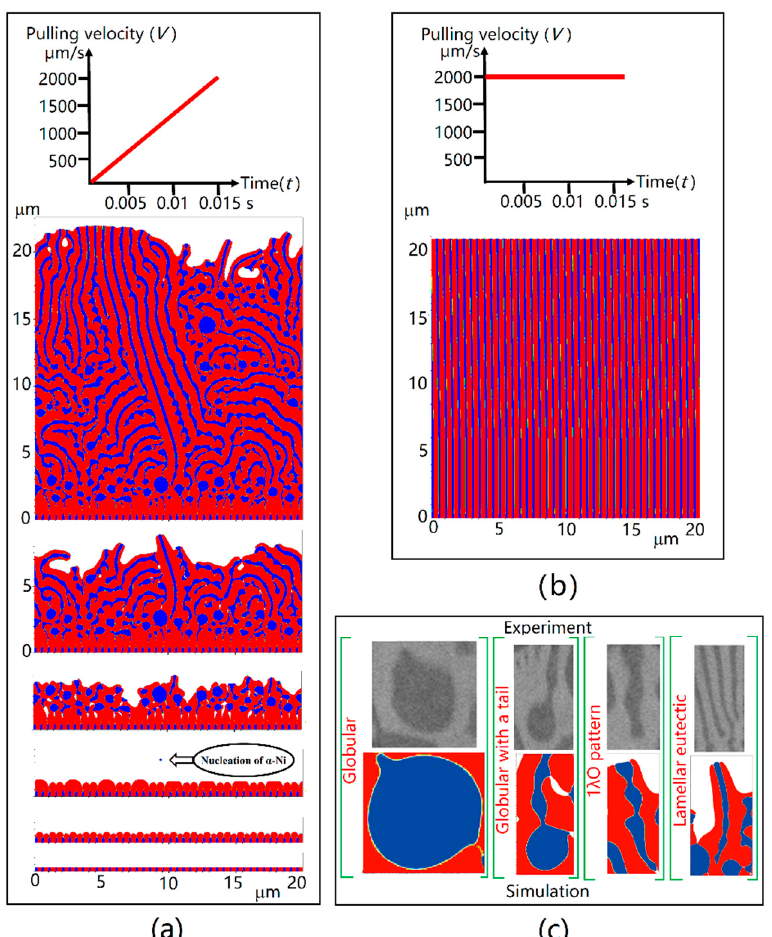
Figure 3. CA simulations of Ni-Sn anomalous eutectic growth under various cooling rates, and the comparison to experiment results: ( a ) temperature gradient G = 1.5 × 10 6 K/m, pulling velocity V linearly increased from 0 µm/s to 2000 µm/s in 0.015 s; ( b ) temperature gradient G = 1.5 × 10 6 K/m, pulling velocity V = 2000 µm/s; ( c ) typical anomalous eutectic morphologies of α -Ni.